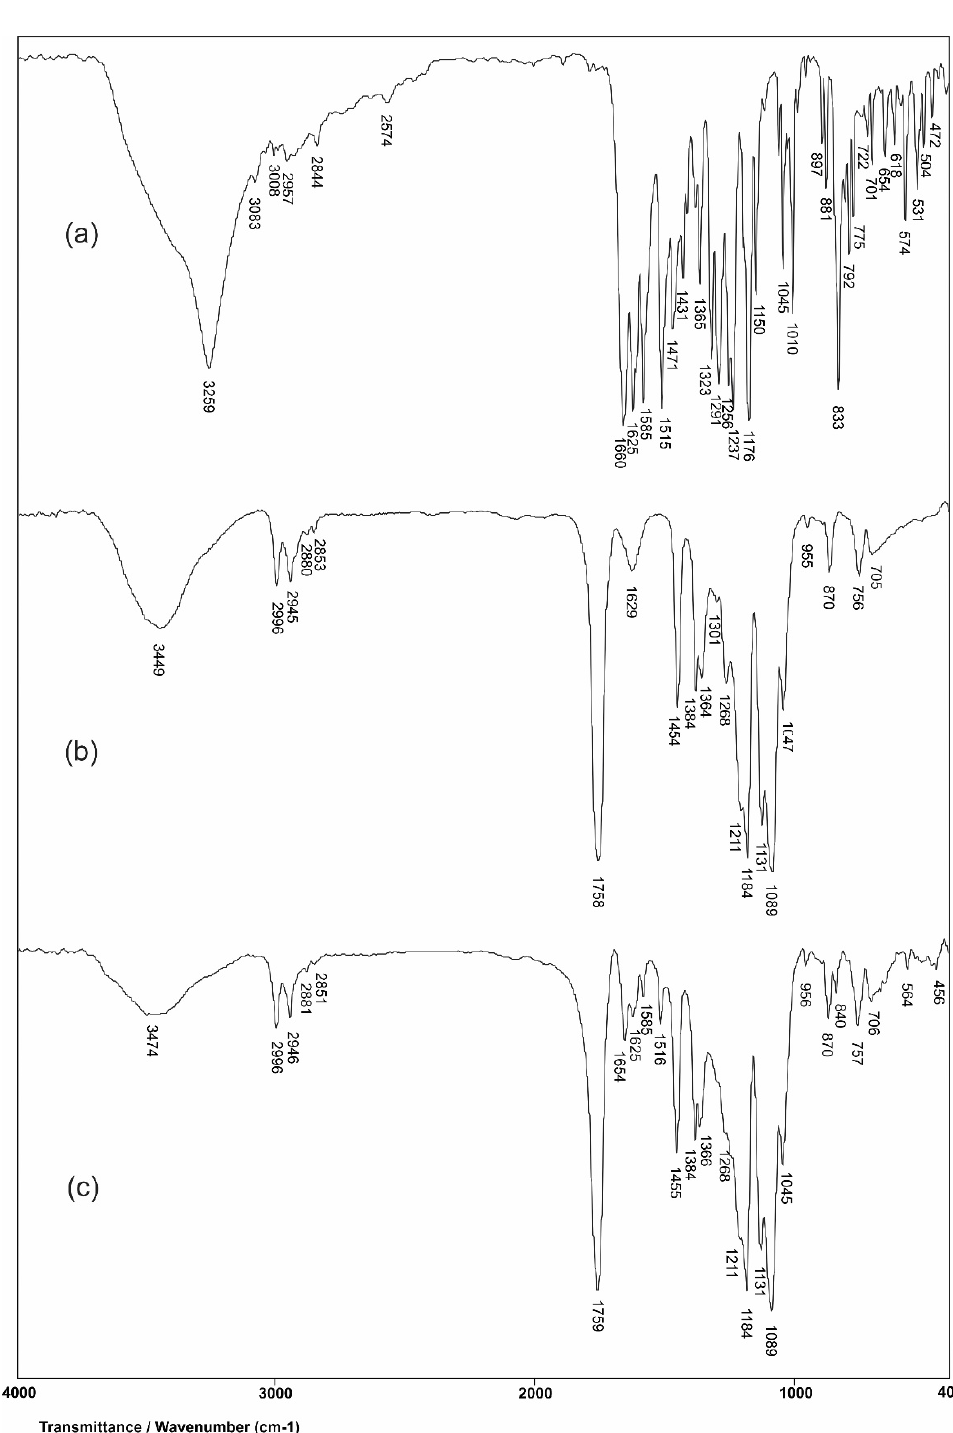
Figure 4. FTIR spectra of: ( a ) biochanin A, ( b ) PLA and ( c ) electrospun PLA-BCA-5% fibers. In the FTIR spectrum of PLA (Figure 4b), two bands are present, with maxima at 2853 and 2945 cm − 1 , respectively, originating from symmetric and asymmetric valence vibrations of C–H bonds that are present. Symmetric and asymmetric valence vibrations of C-H bonds from the CH 3 group give two bands at 2880 and 2996 cm − 1 . A wide absorption band originating from valence vibrations of the hydroxyl group is present in the range of 3200–3600 cm − 1 , and this band has maximum at 3449 cm − 1 in the spectrum of PLA. Symmetric and asymmetric valence vibrations of C–O–C group give two bands